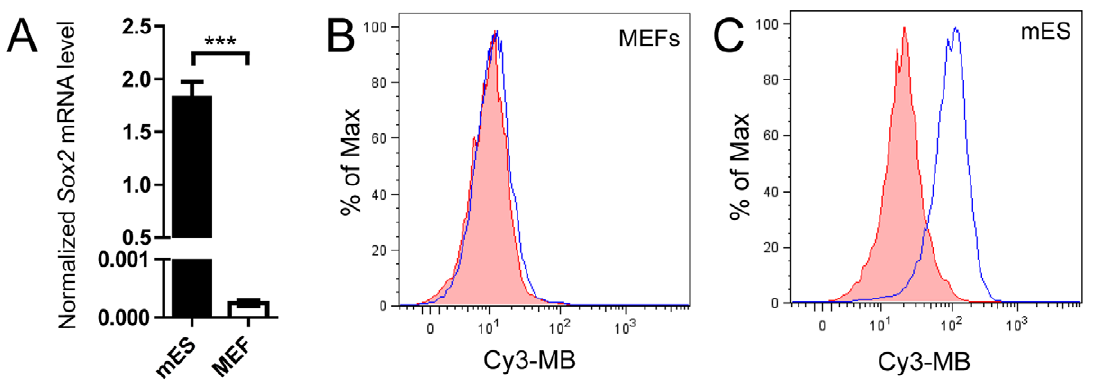
Figure 2. Detection of Sox2 -MB in undifferentiated mES cells as compared to Sox2 -negative MEFs. (A) Sox2 expression in mES cells and MEFs was analyzed by RT-PCR. Fluorescent signals of (B) MEFs and (C) mES cells treated with Sox2 -MB (blue line) and nonspecific-MB (control, red line) as measured by flow cytometry. Error bars represent the mean 6 SEM. Asterisks denotes statistical significance (n=3 samples, *** p , 0.001).